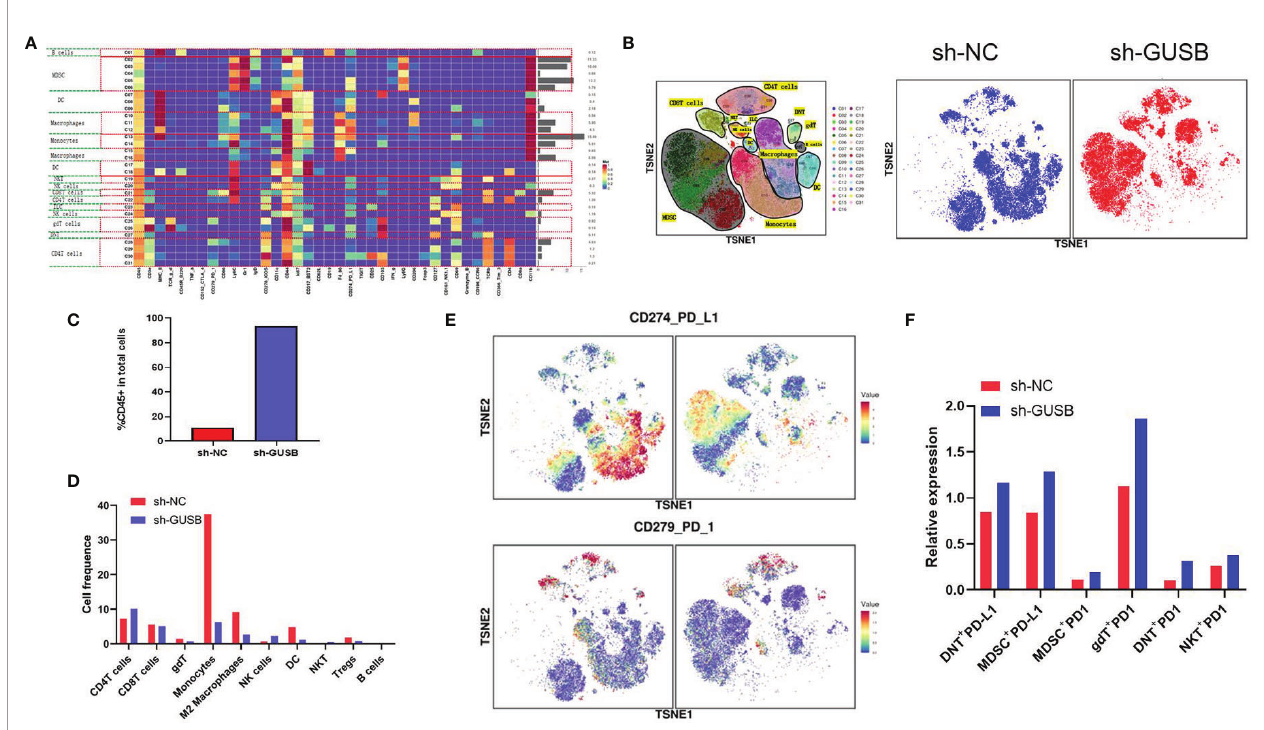
FIGURE 6 | Mass cytometry re fl ected the immune microenvironment of HCC after sh-NC/sh-GUSB treatment. (A) There were 31 cell clusters in total, which were de fi ned in the respective groups. (B) TSNE plot showing the distribution of 31 cell clusters and showing the distribution of cell clusters in the respective samples. (C) The histogram shows the number of CD45 + immune cells in each group. (D) The histogram shows the number of the respective cell clusters in different groups by mass cytometry. (E) TSNE plot showing the distribution of PD1/PD-L1 in two groups. (F) The histogram shows the number of PD1 + cell clusters in different